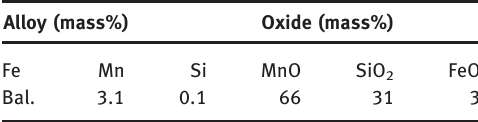
Table 1: Initial compositions of the alloy and oxide used for diffusion couple experiments.